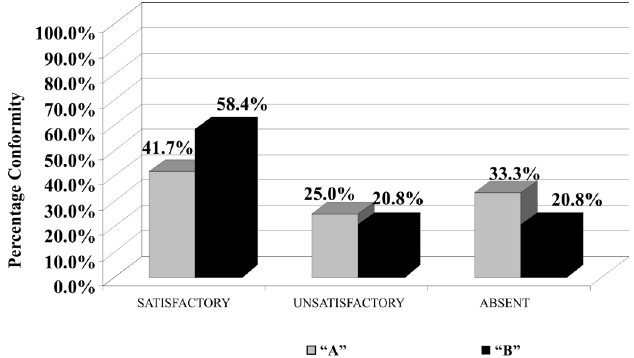
FIGURE 2 - Evaluation of item “Information to patients” in package inserts by manufacturers “A” and “B” for P. sidoide- based